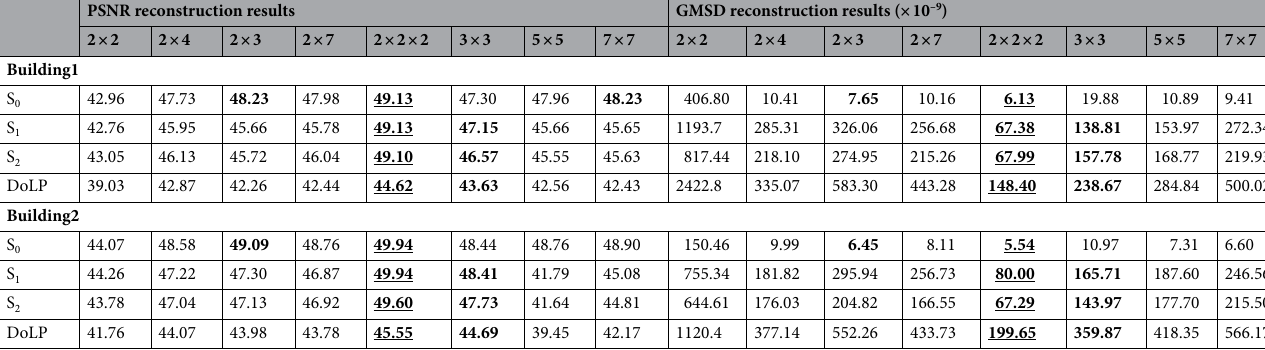
Table 2. Reconstruction results with different